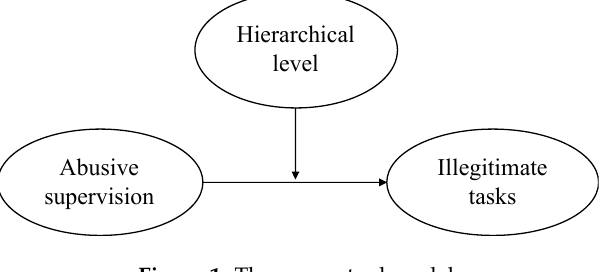
Figure 1. The conceptual model.